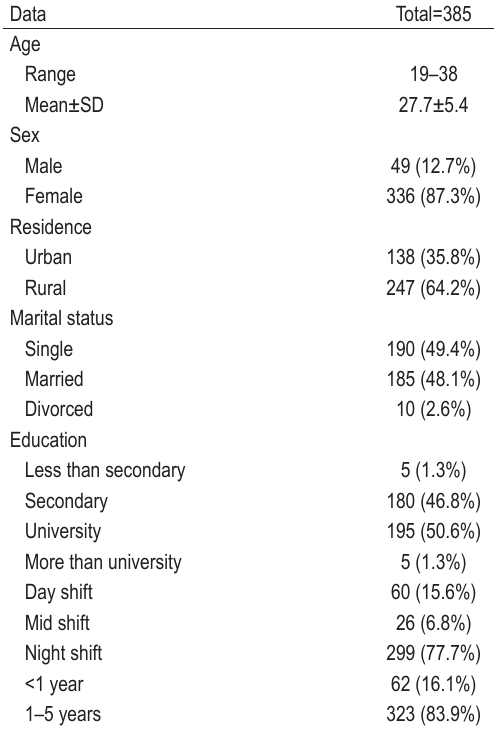
TABLE 1. Distribution of the studied nurses according to their demographic and professional characteristics, Minia